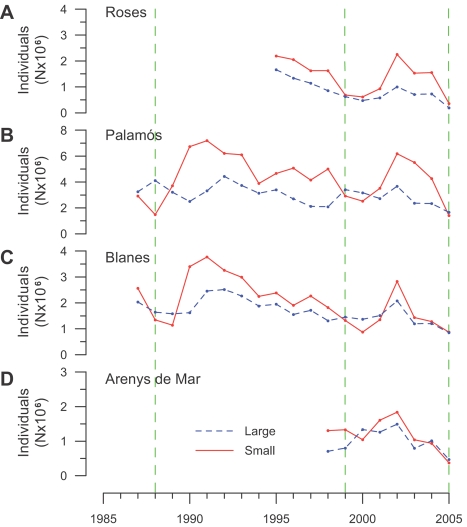
Temporal evolution in population structure.(A–D) Estimation of the abundance of small (continuous red line) and large (dotted blue line) individuals of Aristeus antennatus derived from the annual landings in the studied harbors. Green dashed lines indicate the years when major cascading events occurred. The temporal evolution of the population structure of Aristeus antennatus in all harbors was linked to those cascading events. The number of small individuals increased two and three years after the event, prior the increase in the number of large individuals, indicating that cascading events enhance the recruitment process of this species.